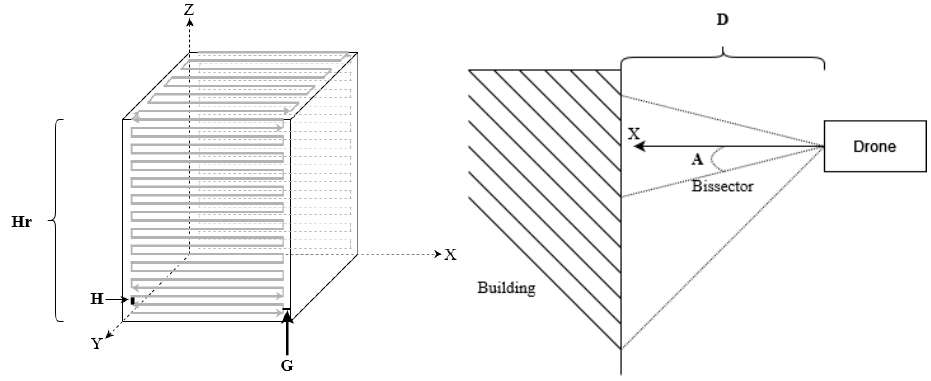
Figure 2. The trajectory of a drone and the